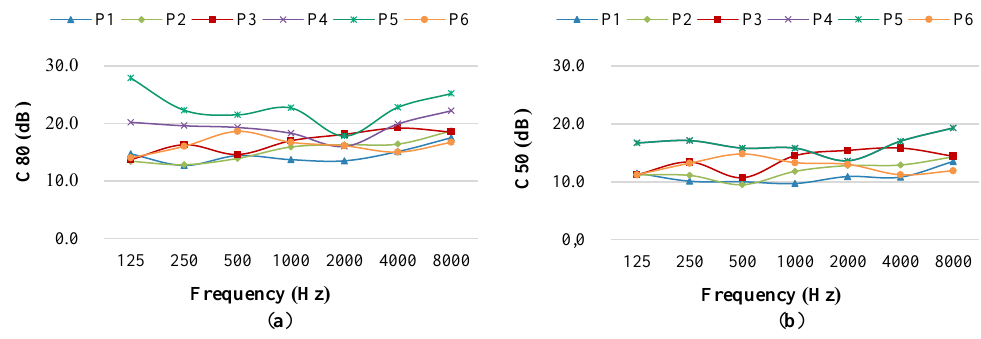
Figure 6. Frequency variation of C80 ( a ) and C50 ( b ) measurements.